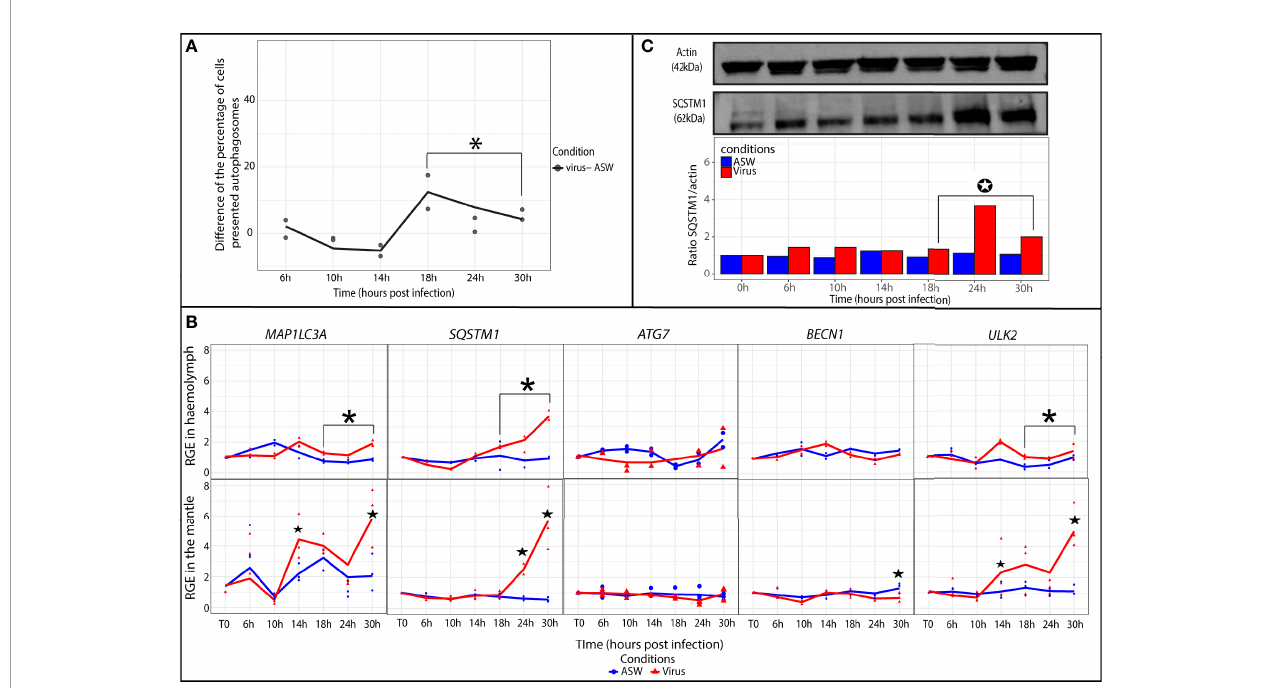
FIGURE 3 | Modulation of the autophagy in Crassostrea gigas exposed to OsHV-1. (A) Monitoring of autophagy in haemocytes of C. gigas by fl ow cytometry. Scatterplot of the difference of the percentage of haemocytes presented autophagosomes between the seawater condition (ASW) and the virus condition from 6 to 30 hpi (n=2 pools of 15 animals). The line represents the trend curve of the difference of percentage of cells between the two conditions. *Signi fi cant increase of the difference of the percentage of cells presented autophagosomes between the virus and seawater condition (p < 0.05). (B) Relative gene expression of key autophagy genes in haemolymph and the mantle of the Paci fi c oysters, C. gigas , in ASW condition (blue) and virus condition (red) at each sampling time point (T0, 6, 10, 14, 18, 24 and 30 hpi) detected by real time PCR (haemolymph: n=2 pools of 15 animals; mantle: n=3 animals). The line represents the trend curve of the expression of each gene in the virus condition (red) and the ASW condition (blue). Signi fi cant difference between the virus and ASW condition at early (6-14 hpi) or late time points (18-30 hpi) of the experimental infection (p < 0.05). Signi fi cant difference between the virus and ASW conditions of the same time point (p < 0.05). RGE, relative gene expression. (C) Detection of the autophagy protein SQSTM1 in the mantle of C. gigas during the kinetic of infection by OsHV-1 in the virus condition at each sampling time point (for each time point n=1 pool of 3 animals). Signi fi cant differences between the virus and ASW condition at early (6-14 hpi) or late time points (18-30 hpi) of the experimental infection (p <